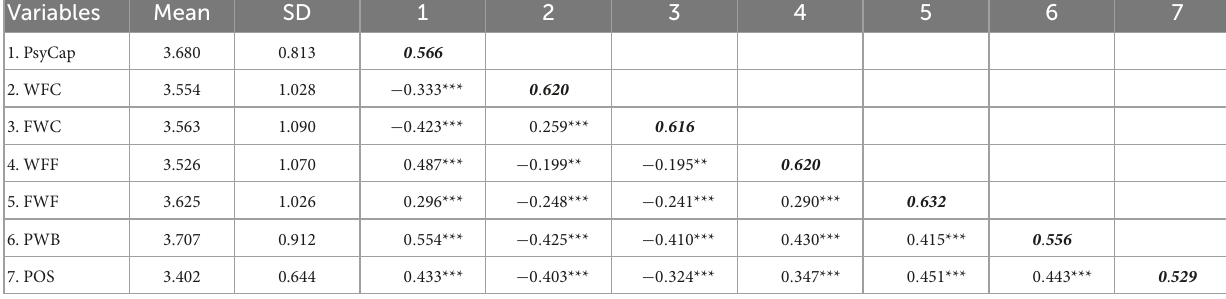
TABLE 2 Means, standard deviations, correlations, and discriminant validity. Variables